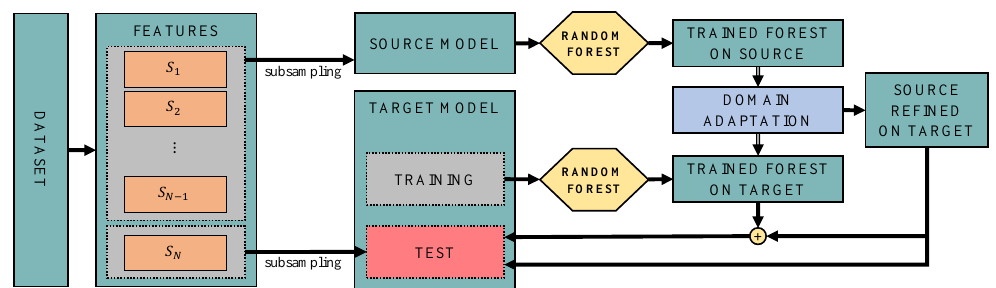
Figure 1. Block scheme for the domain adaptation